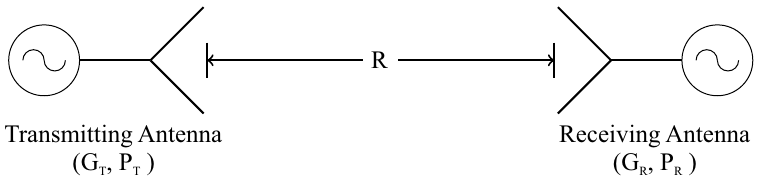
Figure 11. Schematic of the experimental arrangement applied on the gain measurement